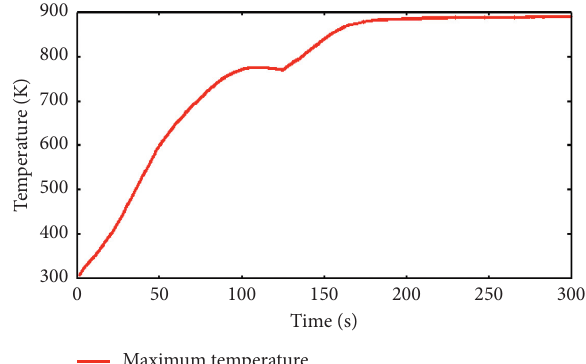
Figure 11: Temperature profile inside the combustion chamber.